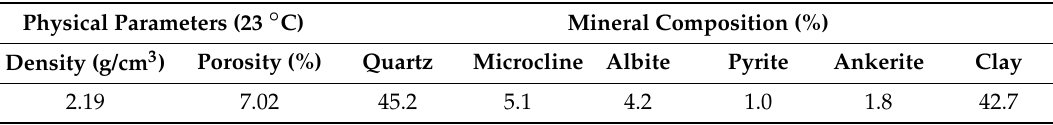
Table 1. Physical parameters and mineral components of the Fushun oil